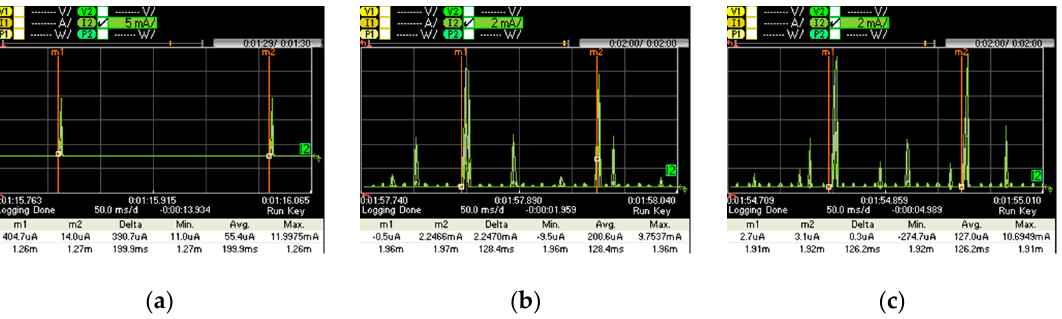
Figure 9. Current consumption of one connection interval without data transmission: ( a ) PCA10028; ( b ) LaunchPad; ( c ) SensorTag.